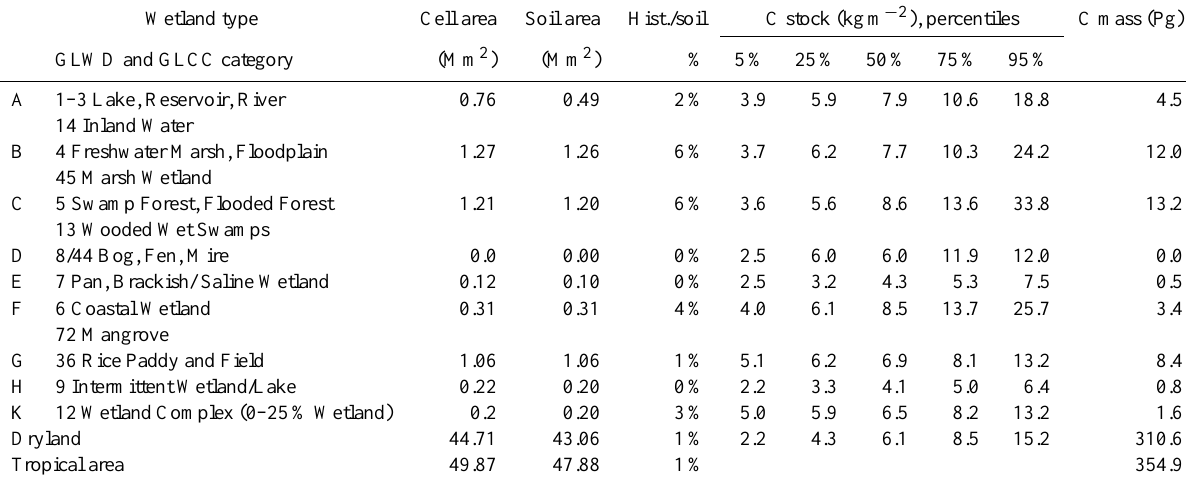
Table 8. Organic carbon stocks and masses in the top 1m of tropical wetland soils derived from HWSD v.1.1-adjusted. Wetlands are classified primarily according to the Global Lake and Wetlands Database (1–12), augmented by wetland classes in the GLCC (13–72). Percentiles refer to the distribution of C stocks in each grid cell within the soil area mentioned. C mass of permanent wetlands (types B–H) is 38.3Pg; that